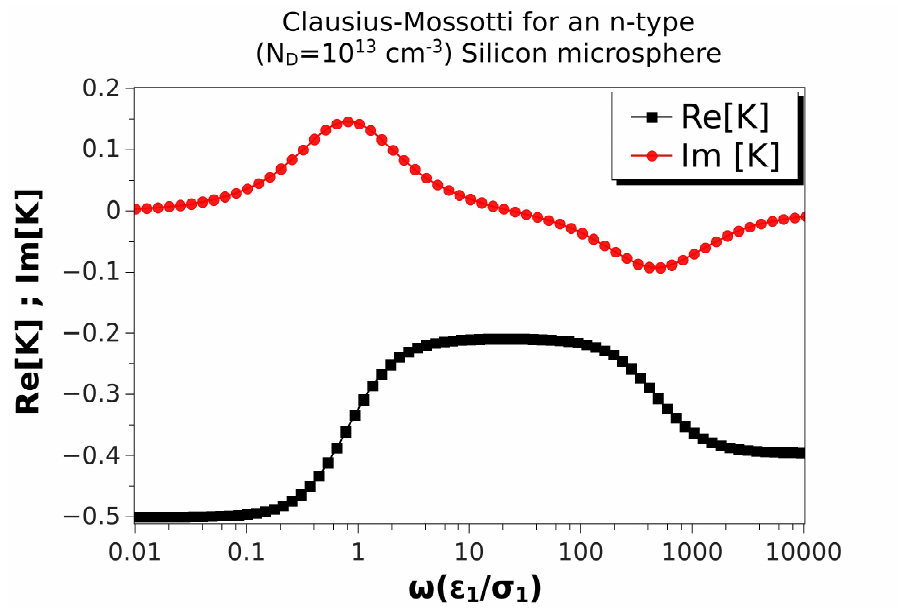
Figure 3. Real and imaginary parts of the Clausius–Mossotti factor versus nondimensional frequency for an n-type silicon microsphere immersed in a KCl solution. Values of the material properties are taken from Table 2. The microsphere is 10 µ m in diameter. Thus, the nondimensional Debye length is ¯ λ = 0.26. D 2